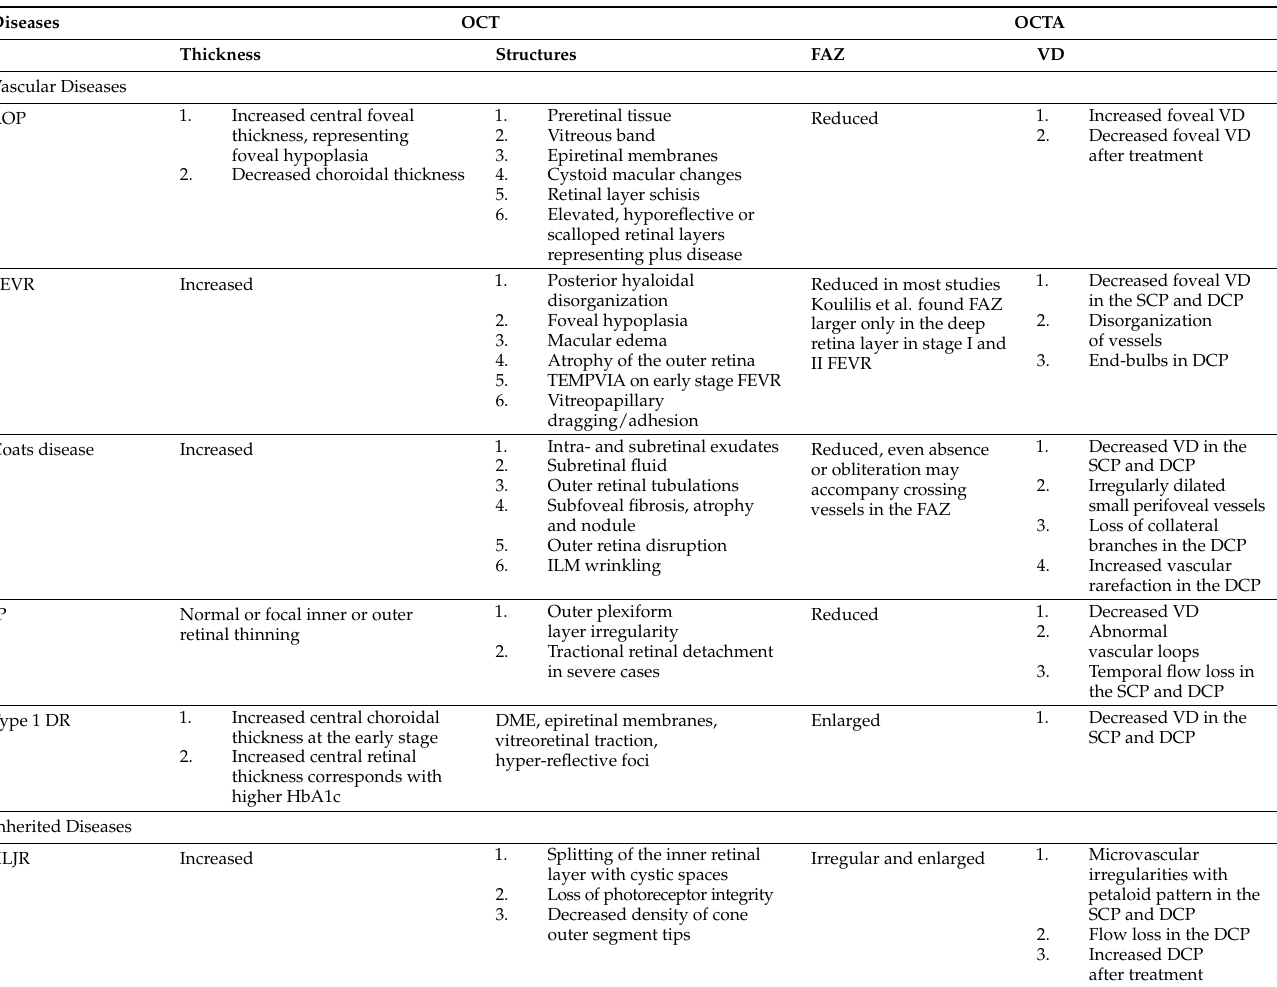
Table 1. Summary of the OCT and OCTA findings and metrics in various pediatric retinal